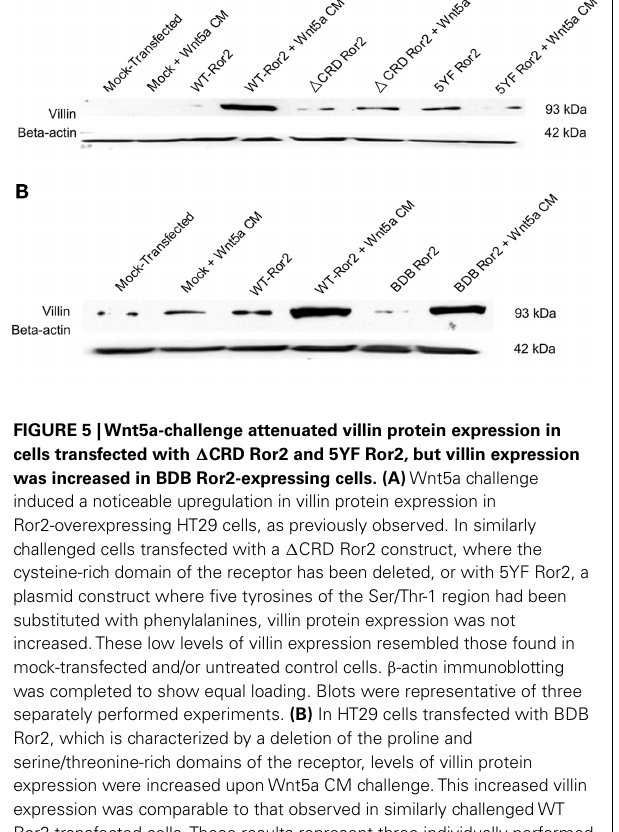
FIGURE 6 | Incubation with recombinantWnt5a, but not recombinant Wnt3a nor EGF enhanced villin protein expression. (A) InWT Ror2-transfected HT29 cells, villin protein was slightly increased compared toWnt5a CM-treated mock-transfected cells.There was a noticeable increase in similarly treatedWT Ror2-overexpressing cells. Incubation with rWnt5a (200ng/mL) for 24h enhanced villin expression to a similar degree. Treatment with rWnt3a (200ng/mL) for 24h did not induce any immunoreactive villin expression. (B) Challenge with EGF (100nM) for 0, 2, 5, 10, 30, 60min induced transient and robust increases in ERK1/2 phosphorylation in HT29 cells. In contrast, weak pERK1/2 immunoreactivity was detected in cells which had been challenged with low serum media, which did not contain EGF, over similar time points. (C) As previously observed, in HT29 cells which were mock-transfected or left untreated, low levels of villin protein expression were detected. InWT Ror2-overexpressing cells challenged withWnt5a conditioned media for 24h, villin protein expression was increased. InWT Ror2-overexpressing cells, challenged with EGF for a similar 24h time period, low levels of villin expression were detectable, comparable to that found in mock-transfected or untreated control cells. β -actin immunoblotting was included as a loading control.These results are representative of three separately performed